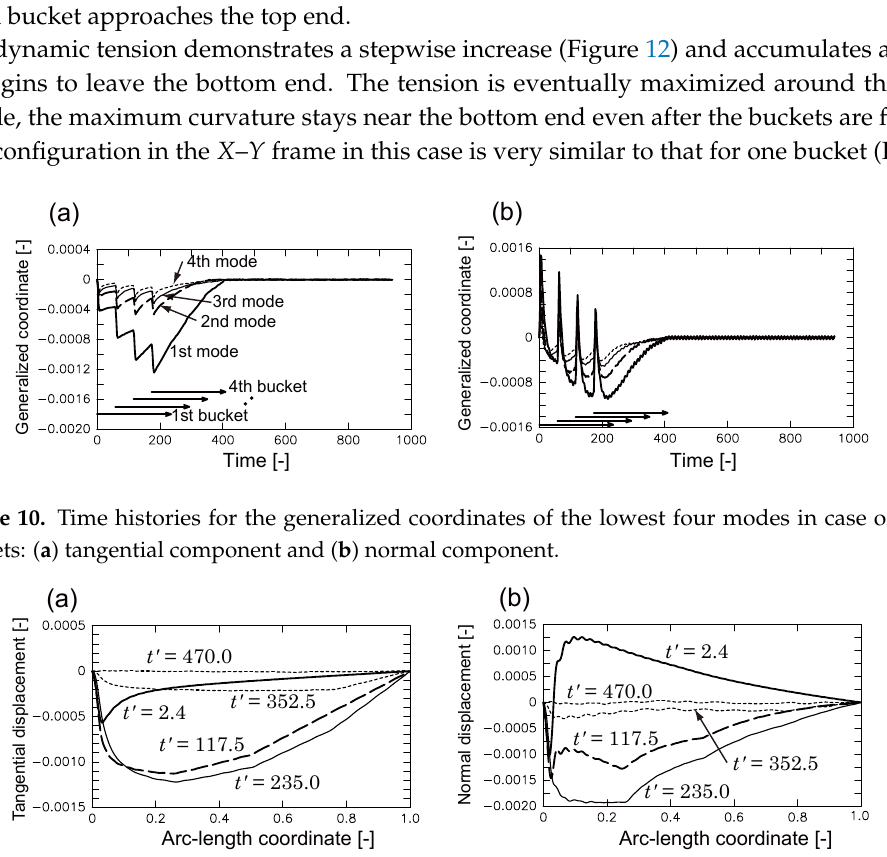
Figure 11. Distributions of the ( a ) tangential and ( b ) normal displacements for four buckets. t (cid:48) denotes dimensionless time.